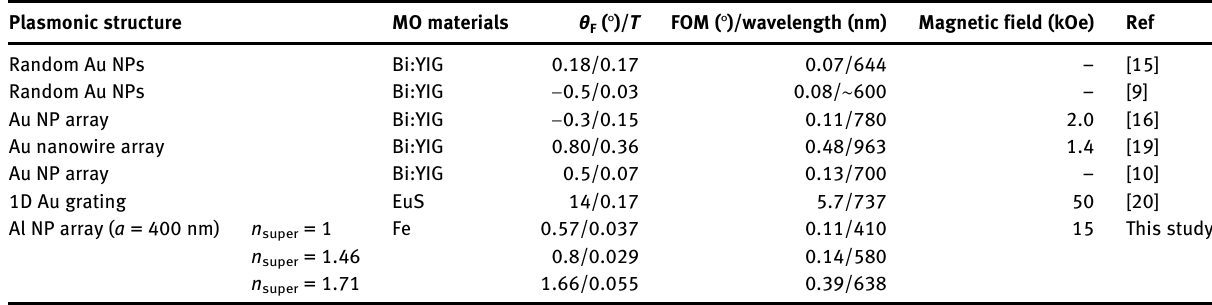
Table  : Preceding and present experimental works on enhanced Faraday rotation (FR) by fi lm-based magnetic systems coupled to localized surface plasmon resonances (LSPRs). Plasmonic